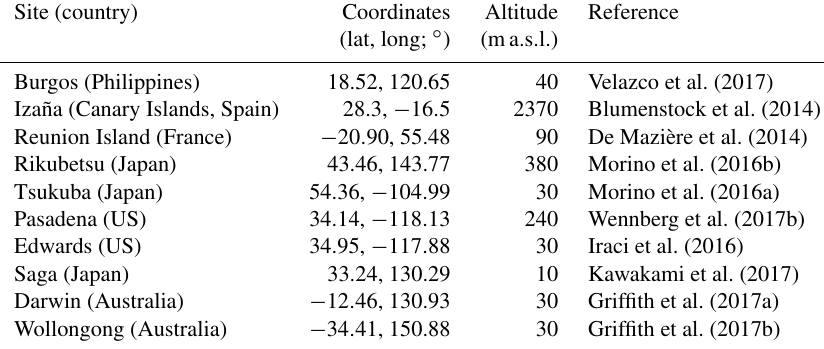
Table B1. Overview of the stations from the TCCON network used for validation of ocean sun glint measurements in Sect.